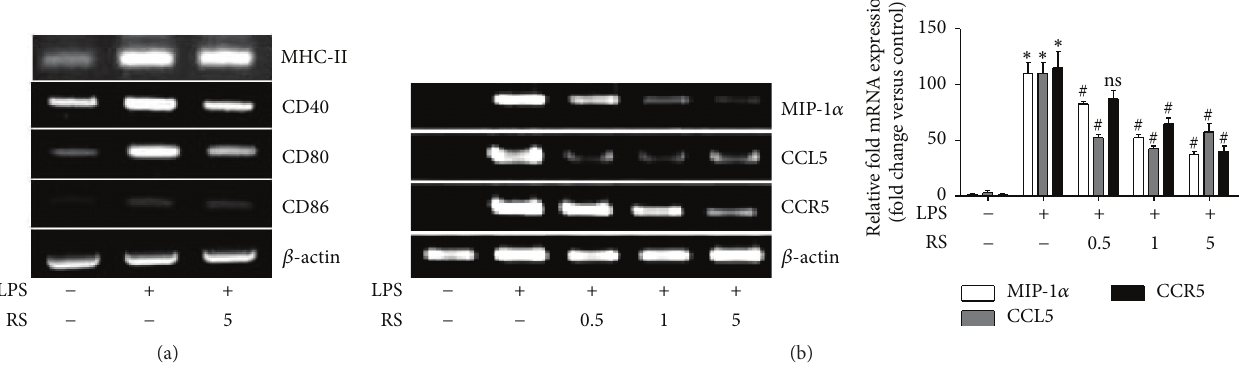
Figure 5: LPS-Rs inhibit costimulatory molecules and leukocyte trafficking factors required for T cell interaction and infiltration. BV2 microglia were pretreated with LPS-Rs for 2hrs followed by LPS treatment for 6 hrs and the mRNA expression of macrophage activation markers: MHC-II, CD40, CD80, and CD86 (a) and chemokines and chemokine receptors (MIP-1 𝛼 , CCL5, and CCR5) (b) were detected by RT-PCR. The error bars represent the mean ± SEM from three independent experiments ( ∗ 𝑝 ≤ 0.05 versus control and # 𝑝 ≤ 0.05 versus LPS). UN: untreated; LPS: lipopolysaccharide from Escherichia coli 055 : B5 (1 𝜇 g/mL); RS: lipopolysaccharide from Rhodobacter sphaeroides (0.5–5 𝜇